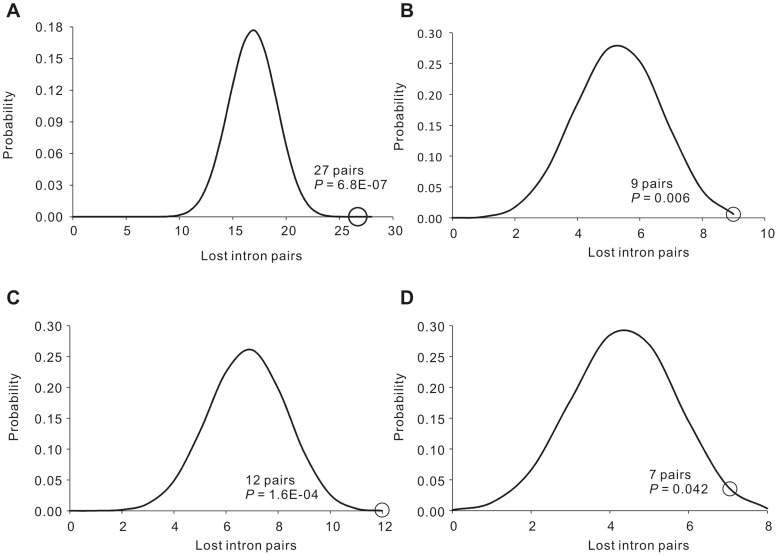
Adjacent introns tend to be lost together in fission yeasts.The probability distribution of all possible numbers of adjacent lost intron pairs is shown, with the observed pattern marked by a circle. The probabilities exceeding the observed numbers of lost intron pairs were small and, therefore, adjacent introns tend to be lost together more frequently than by chance. Lost introns are categorized by A) S. pombe, B) S. japonicus, C) Ancestor of S. cryophilus, S. octosporus and S. pombe, D) Ancestor of S. cryophilus and S. octosporus.